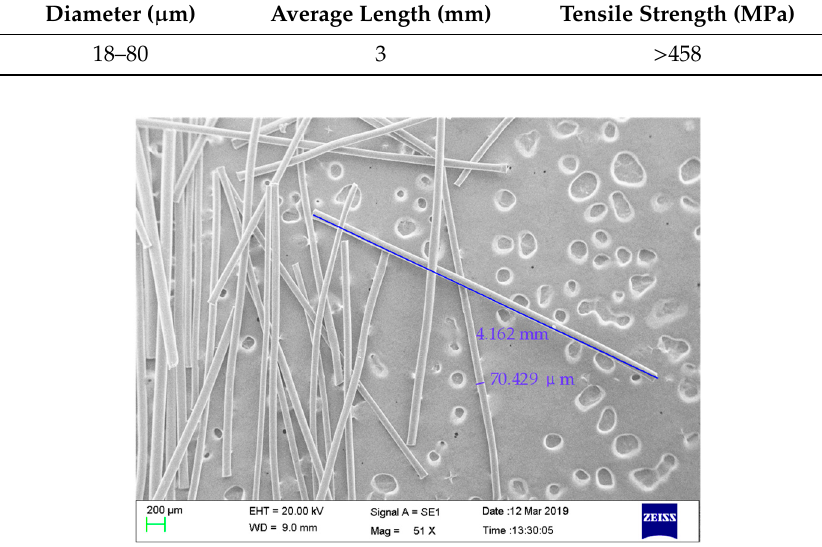
Table 1. Physical properties of polypropylene fiber utilized.